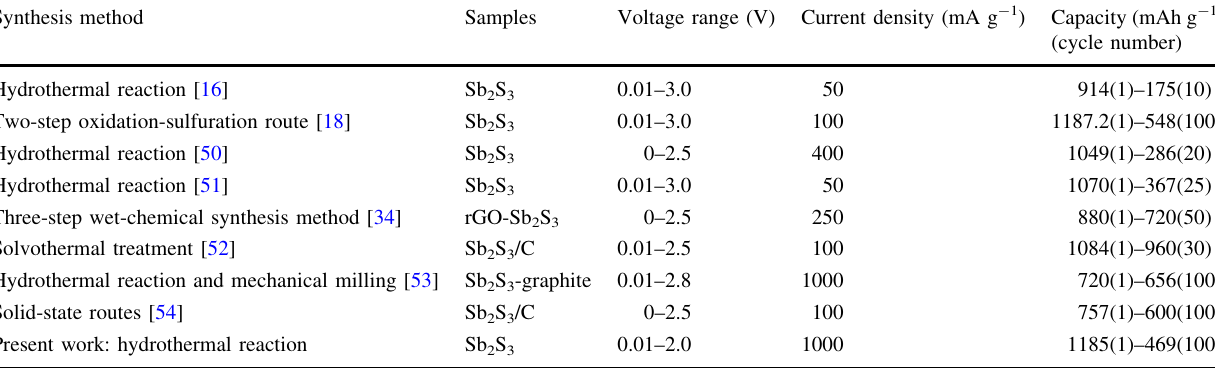
Table 2 Comparison of the performance between hierarchical Sb 2 S 3 hollow microspheres with other reported Sb 2 S 3 in studies as anode materials for LIBs Synthesis